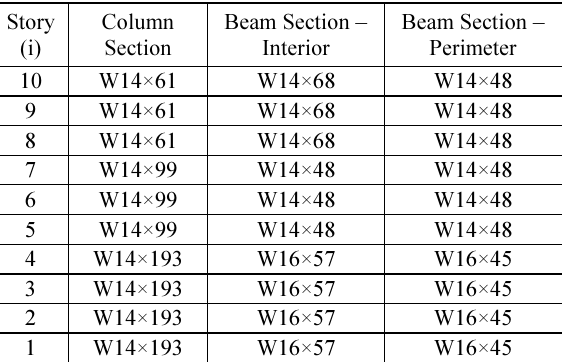
Fig. 5. Three-dimensional building structures studied in this research Table 1. Member designs for Moment Resisting Frame (MRF)